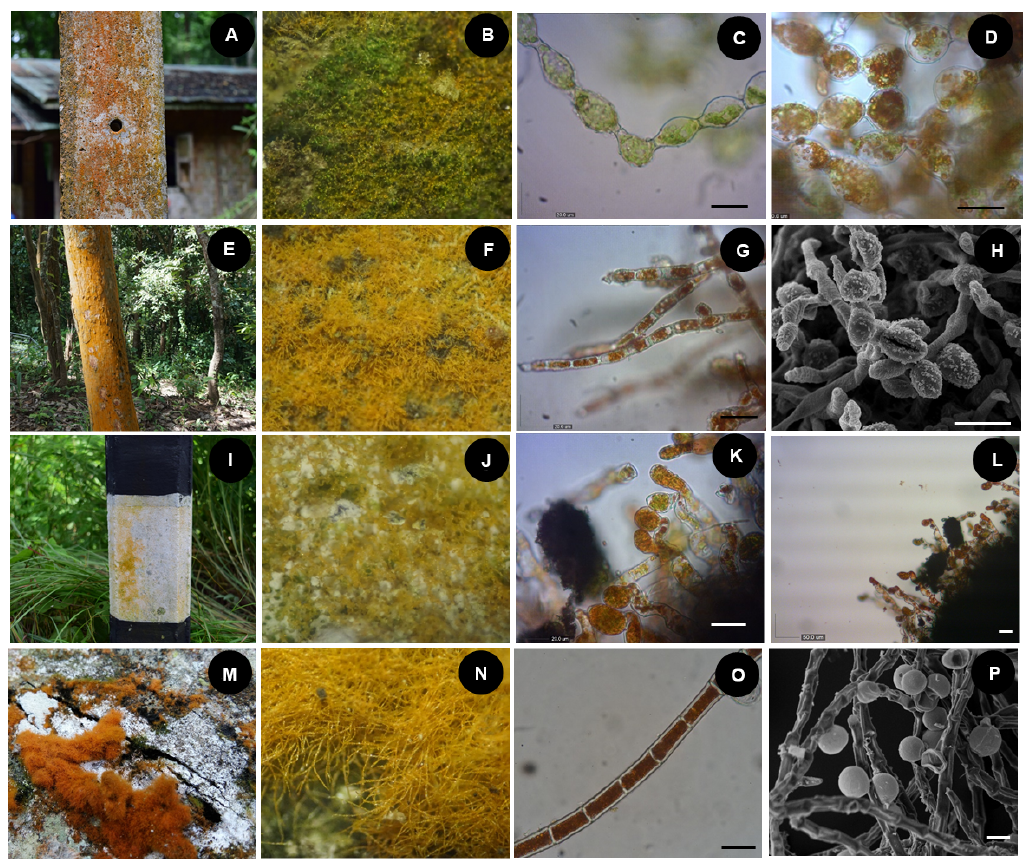
Figure 5 Subaerial green algae genus Trentepohlia at 13 sampling points in the rainy, winter, and summer seasons, including T. monilia ( A–D ), T. abietina ( E–H ), Trentepohlia sp. 5 ( I–L ), and T. aurea ( M–P ). Scale bars: 20 µ m.